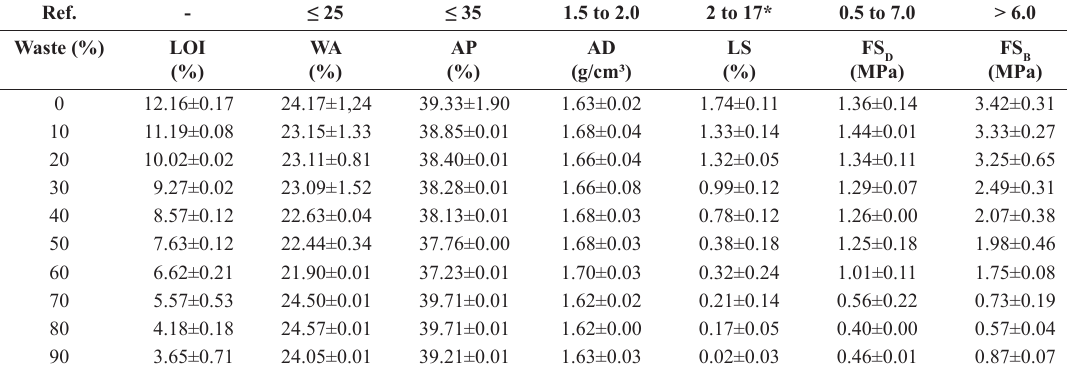
Table 3. Ceramics characteristics of clayey mass with dimension stone waste in contents ranging from 10% to 90% and solely of clay (0%) - averages and standard deviations.